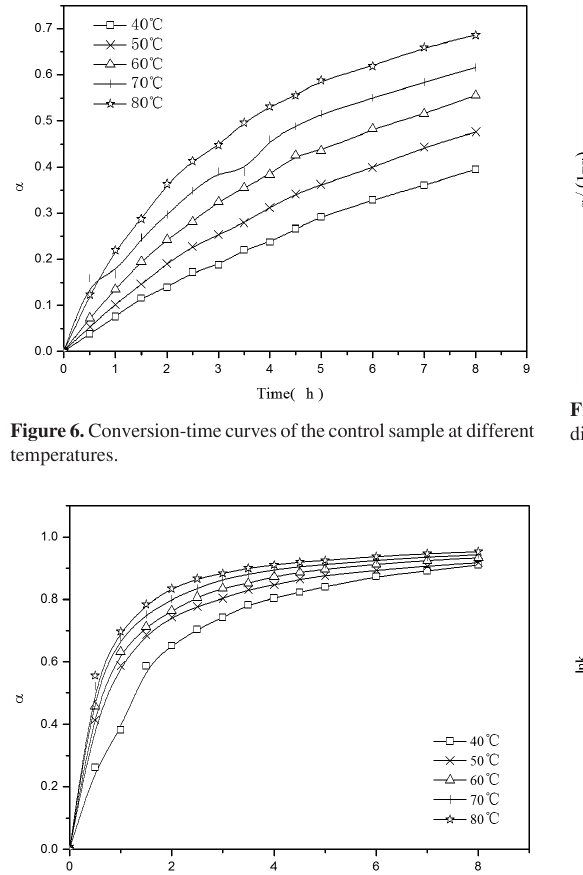
Figure 10. Plots of lnk - 1000/ T for the H-IPNs systems and the control sample.